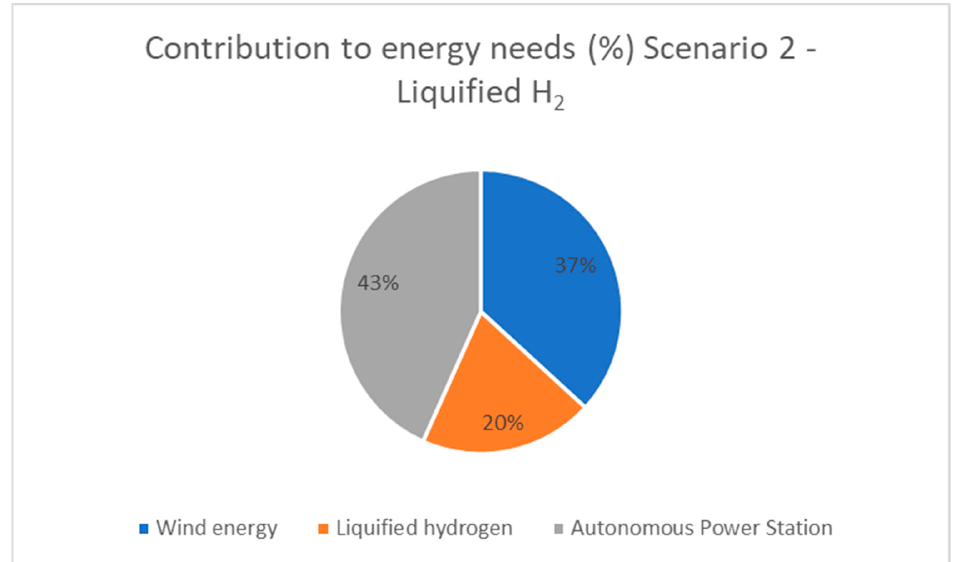
Figure 14. Monthly average contribution to energy needs.